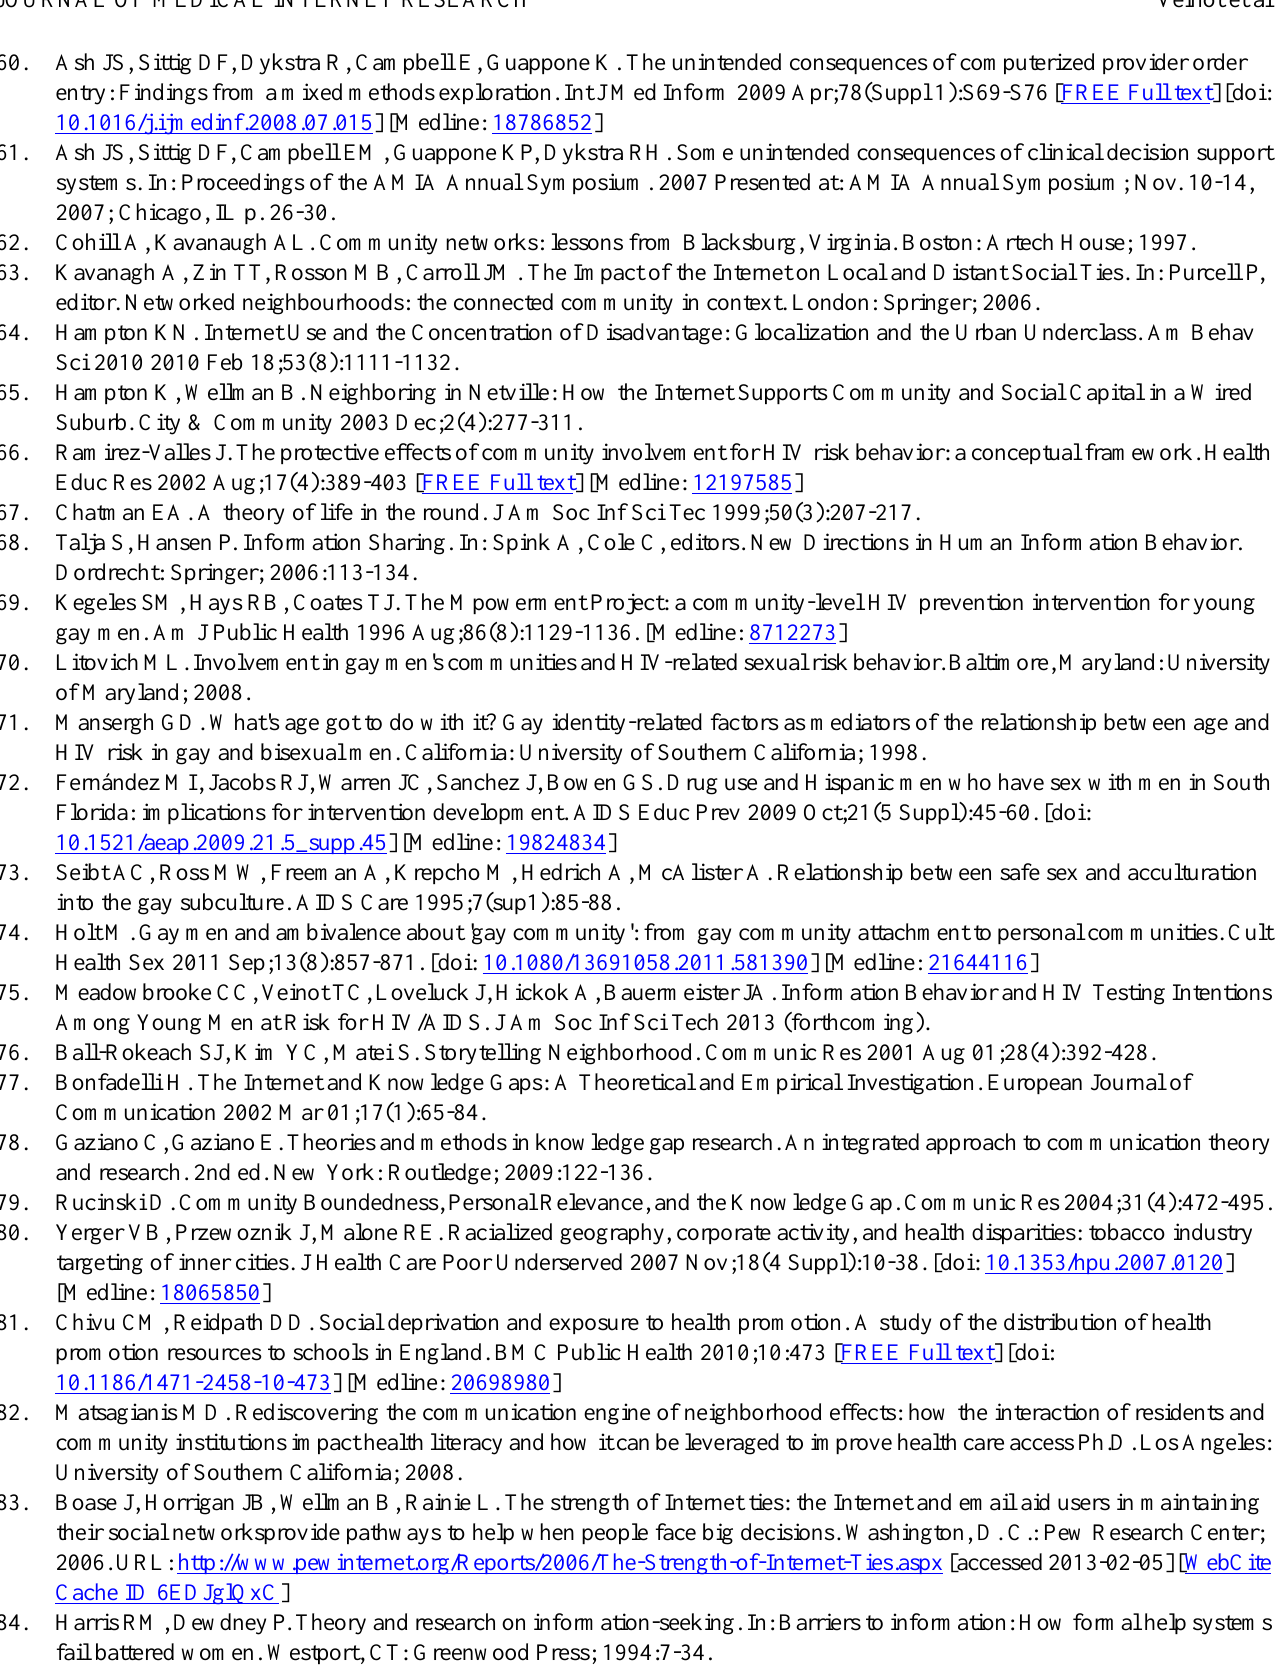
ASO: AIDS Service Organization CHI: consumer health